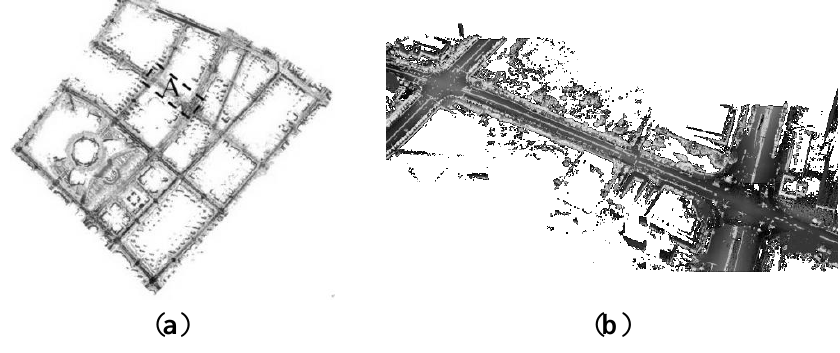
Figure 2. Experimental data. ( a ) Vehicle-borne LiDAR points. ( b ) Experimental